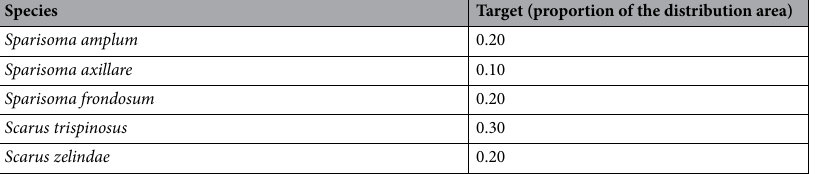
Table 1. Targets used in the prioritization analyses for four parrotfish species: Scarus trispinosus; Scarus zelindae ; Sparisoma amplum ; Sparisoma axillare ; Sparisoma frondosum